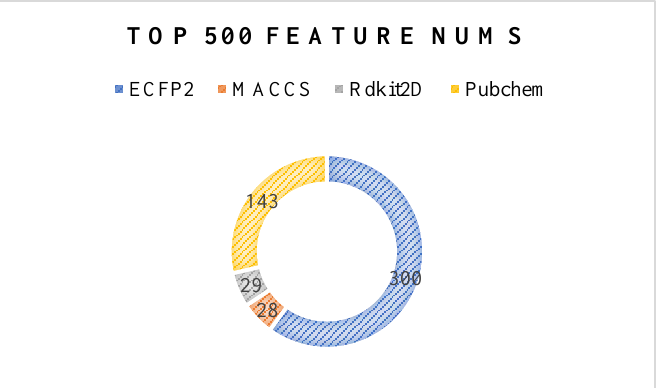
Figure 9. Results of the top 500 features of feature importance were obtained by counting the frequency of features in k feature subsets of all individuals in the last generation.